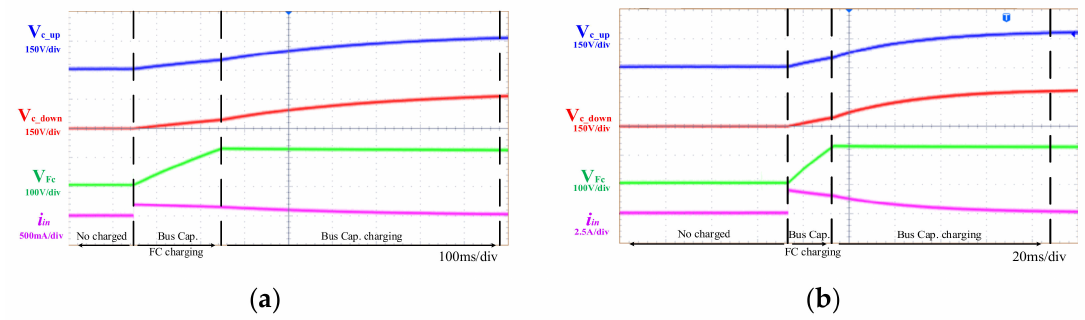
Figure 20. Soft start-up under different charging resistance. ( a ) R1 = 500 Ohms; ( b ) R1 = 50